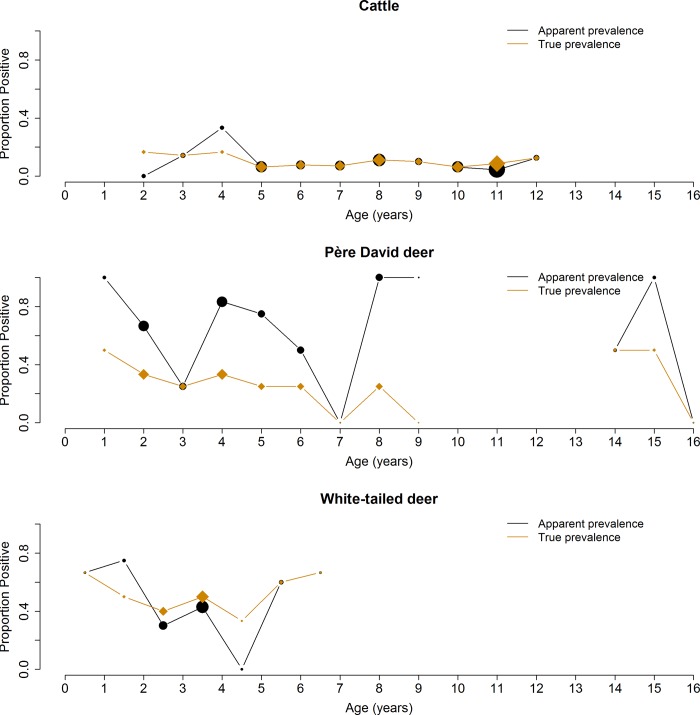
Apparent and true prevalence of proportion positive individuals by species and age.The size of the circles or diamonds is proportional to the number of animals sampled at each age.